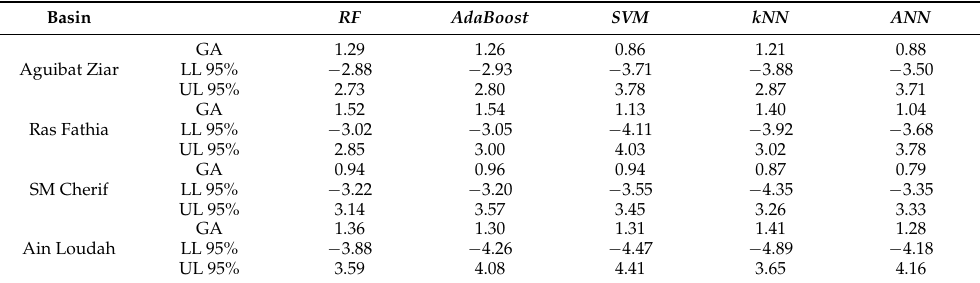
Table 7. Generalization ability, lower limit errors, and upper limit errors of the models.